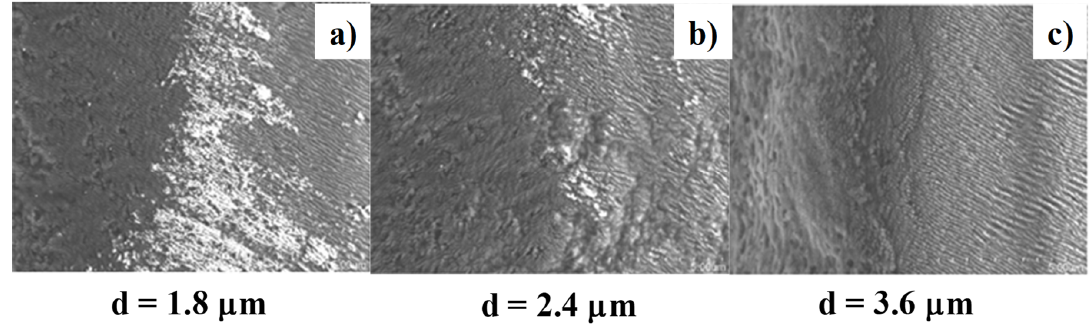
Figure 6. Comparison of the SEM images of the nanotextures formed onto the trimmed diamond coatings among the three diamond-coated punches with different depths (d) of cut. ( a ) d = 1.8 μm, ( b ) d = 2.4 μm, and ( c ) d = 3.6 μm.